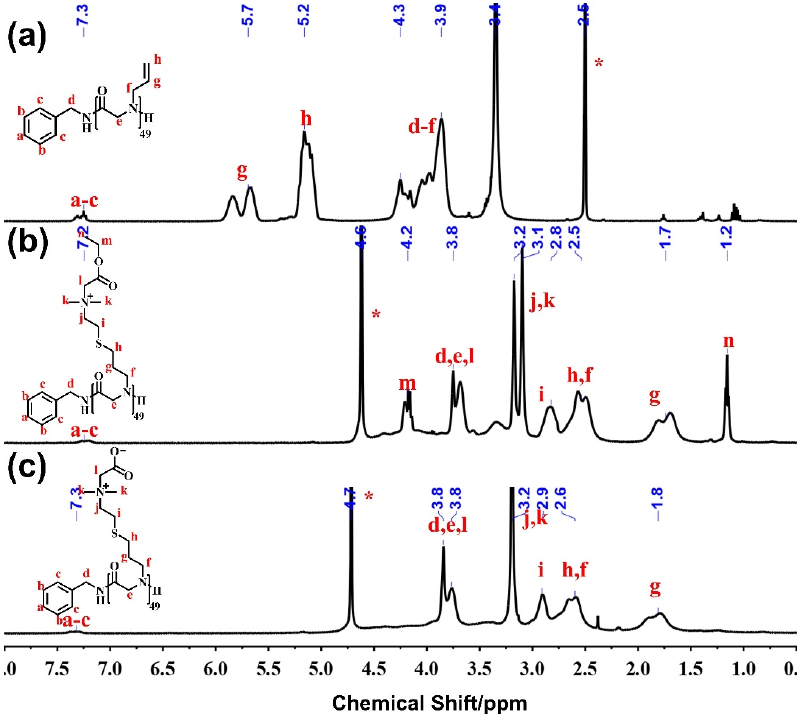
Figure 1. 1 H NMR spectra of CB-modified homopolypeptoids ( a ) PNAG, ( b ) PeptoidQA-1, and ( c ) Peptoid CB-1. * represents the solvent.